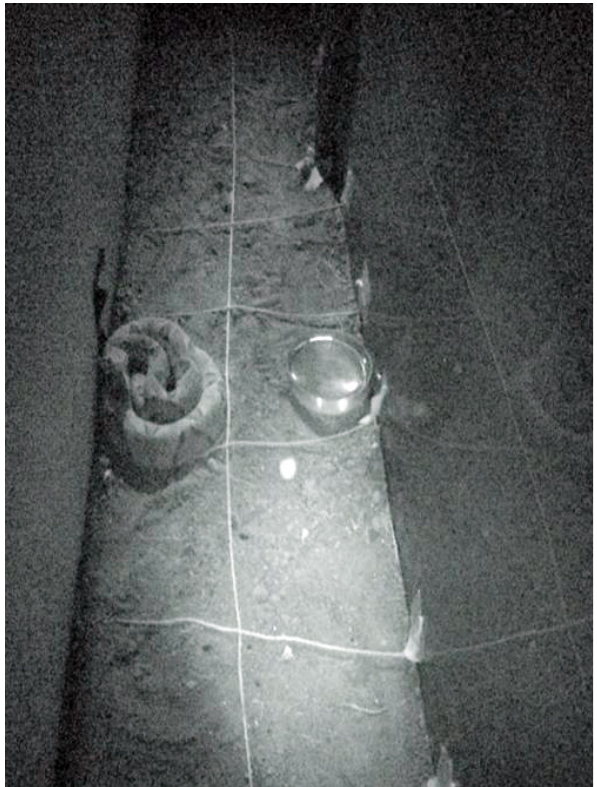
Figure 1. Arena during